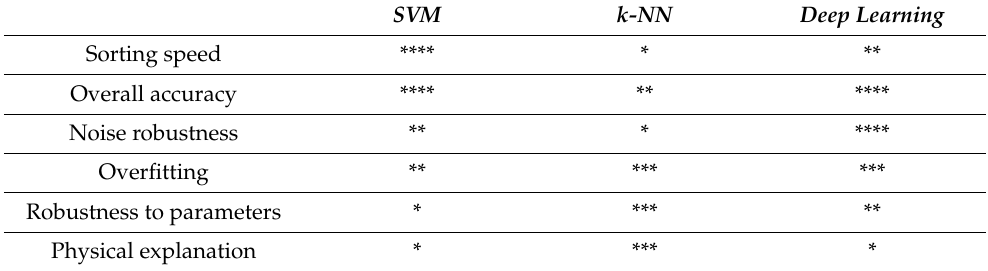
Table 2. Performance